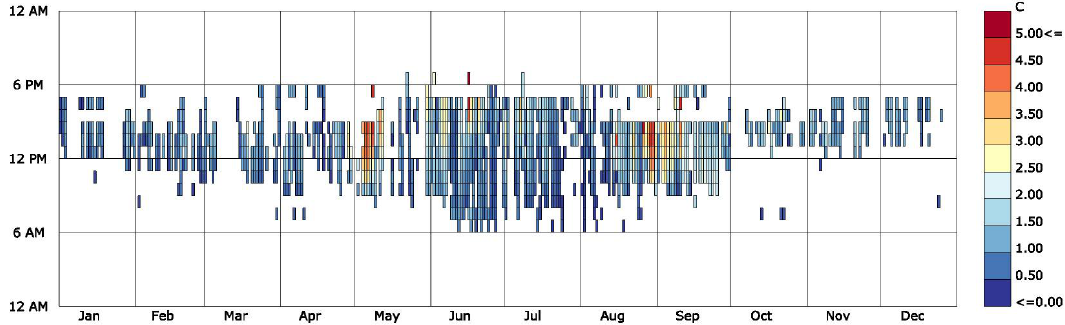
Figure 5. Hourly ambient temperature differences of AT-Green vs. AT-Black.